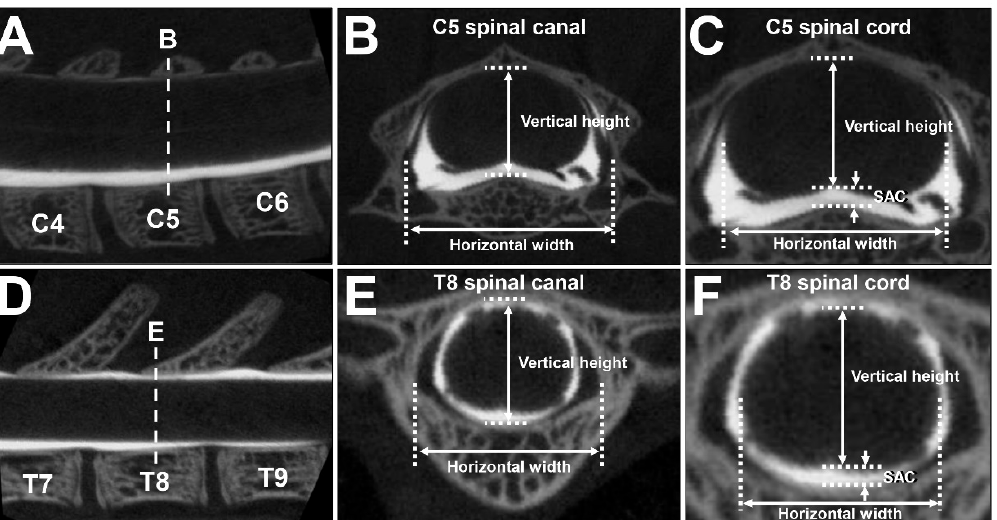
Figure 6. Measurement of the spinal canal and the spinal cord. ( A – F ) CTM images of an 8-week-old female rat. ( A ) Sagittal image of CTM of the cervical spine. Dotted line indicates the slice for which a coronal image ( B , C ) was measured. ( B ) Coronal image of the spinal canal at C5. Two-headed arrows indicate the vertical height and horizontal width of spinal canal for measurement. ( C ) Coronal image of the spinal cord at C5. Two-headed arrows indicate vertical height and horizontal width of spinal cord for measurement. One-headed arrows indicate vertical SAC. ( D ) Sagittal image of CTM of the thoracic spine. Dotted line indicates the slice for which a coronal image ( E , F ) was measured. ( E ) Coronal image of the spinal canal at T8. Two-headed arrows indicate vertical height and horizontal width of spinal canal for measurement. ( F ) Coronal image of the spinal cord at T8. Two-headed arrows indicate vertical height and horizontal width of the spinal cord for measurement. One-headed arrows indicate vertical